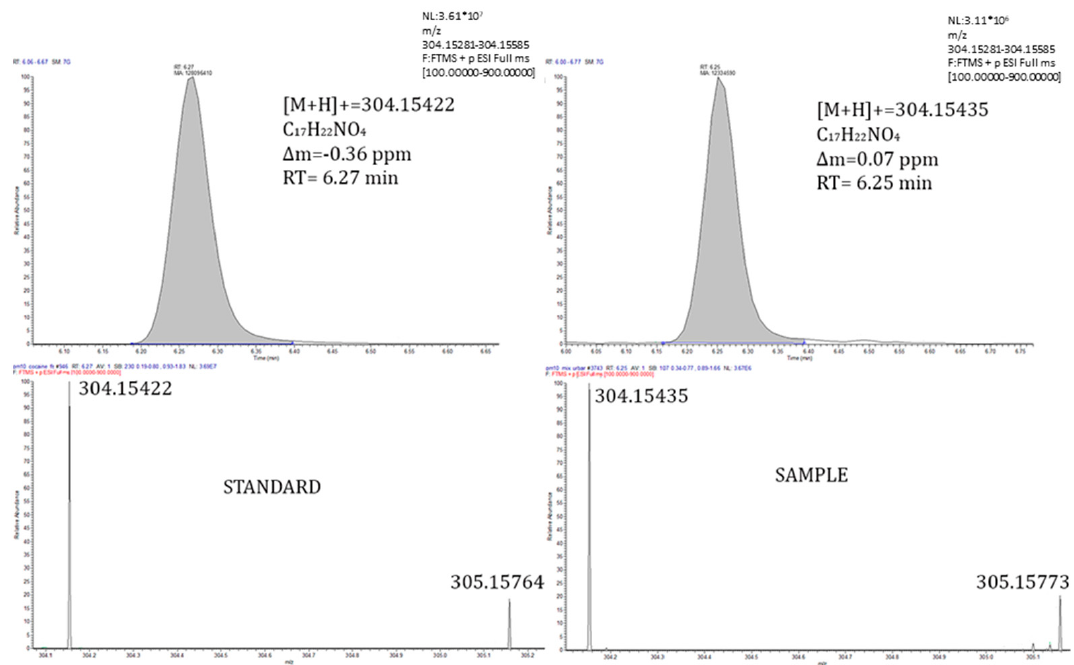
Figure 5. Extracted ion chromatogram ( top ) and isotopic profile ( bottom ) corresponding to the protonated molecule of cocaine in a standard ( left ) and a real sample ( right ).